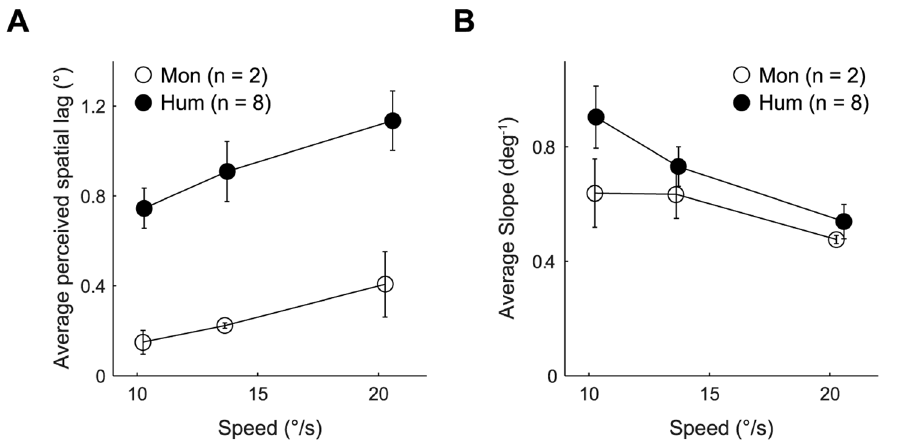
Figure 4. Comparison of illusion characteristics in monkeys and humans. (A) Perceived lag in monkeys (open circles) and humans (filled circles) averaged over subjects as a function of speed of the moving bar. Error bars: 6 1SEM.(B) Slope of the psychometric function averaged over subjects. Coding and error bars as in A.